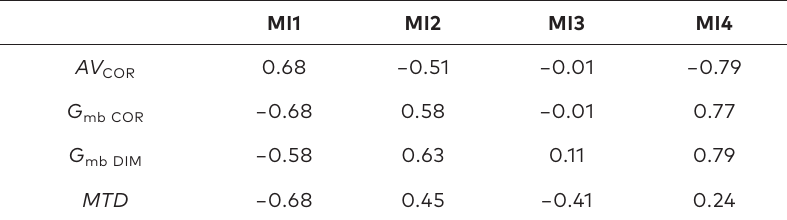
Table 11. Pearson coefficients